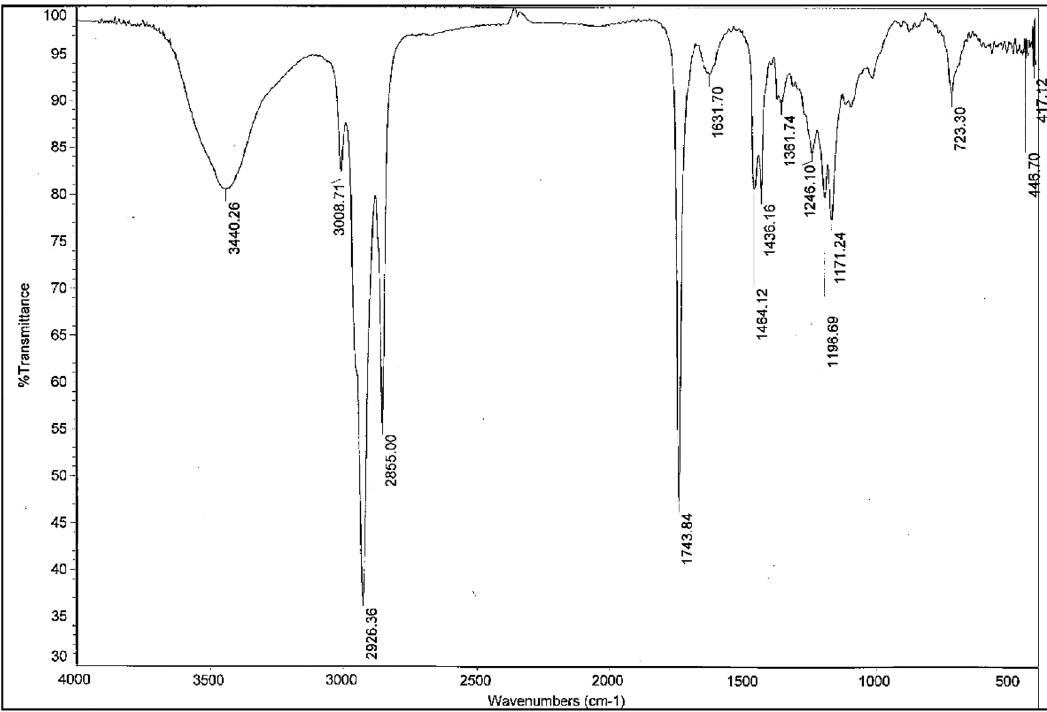
Figure 10. FTIR analysis of fatty acid methyl esters (biodiesel) produced from the enzymatic transesterification and enzymatic esterification process of cooking oil waste.